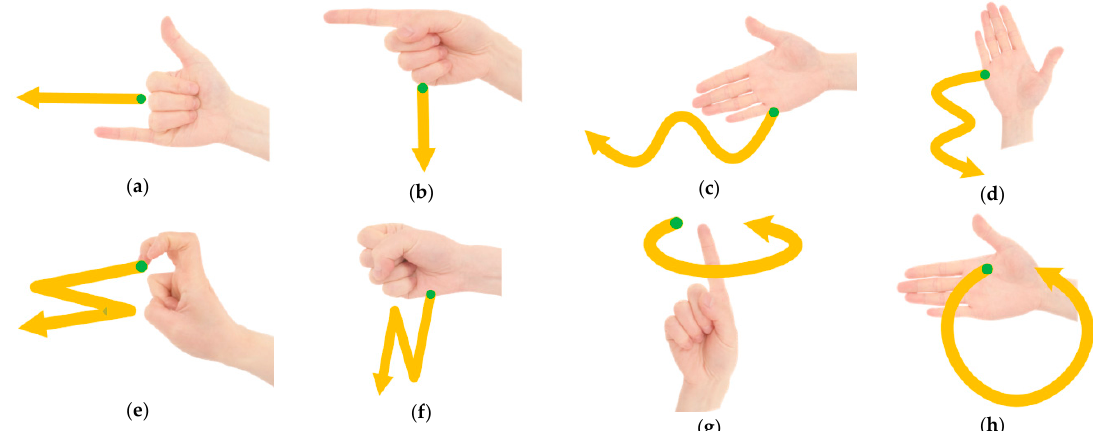
Figure 1. Schematic showing the trajectory recognition steps.